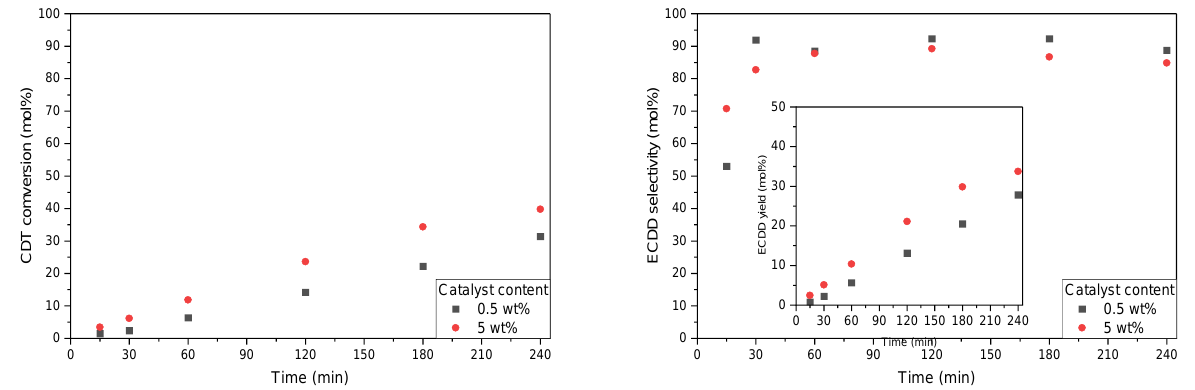
Figure 10. Graphs showing conversion of CDT ( left ), selectivity of transformation of CDT to ECDD ( right , main), and ECDD yield in relation to CDT ( right , insert) at different catalyst contents in the processes conducted using a semi-bath method. Process conditions: temperature, 60 °C; solvent, i- PrOH, 90 wt%; catalyst, W-SBA-15; CDT:H 2 O 2 (9.54 wt% i-PrOH solution) molar ratio, 2.